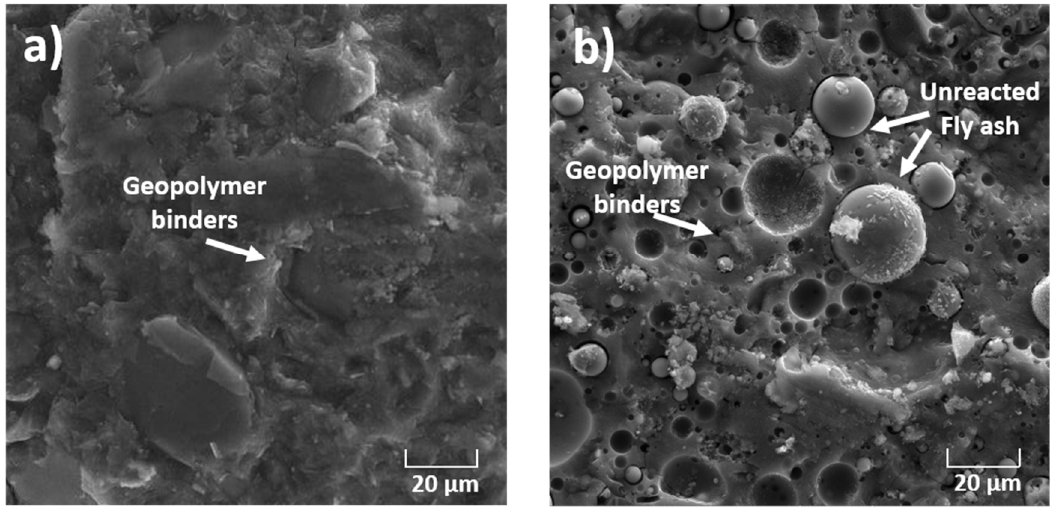
Figure 6. SEM micrographs of ( a ) BGMK and ( b ) BGFA geopolymer binders.